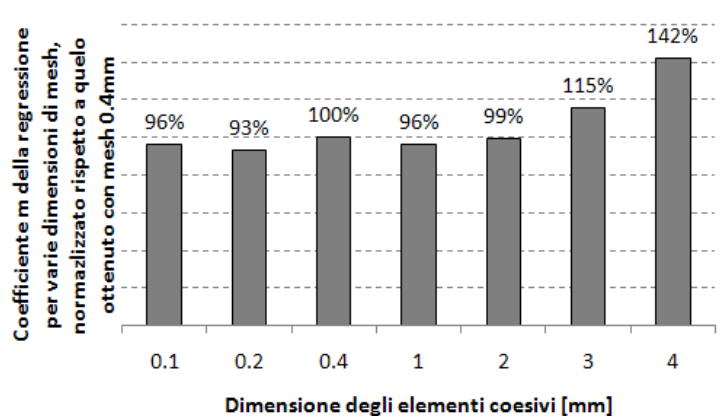
Figura 10: Influenza della dimensione della mesh sulla pendenza della regressione dei risultati delle simulazioni. Si può notare come da mesh molto fitte (0.01mm) fino a 2 mm, non vi sia una grossa differenza dei risultati. Aumentando ancora la mesh si nota invece come i risultati si discostino sempre di più.